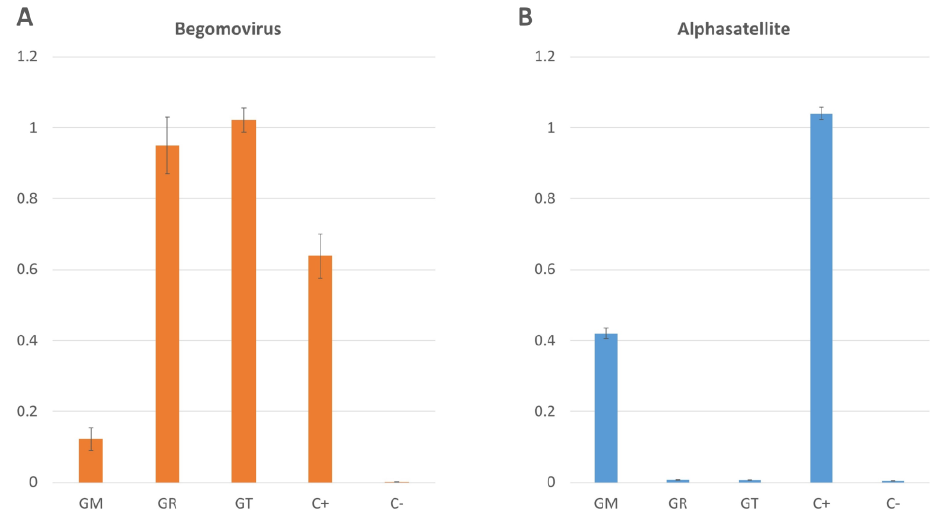
Figure 4. Quantitative analysis of begomovirus and alphasatellite. ( A ) qPCR with begomovirus specific primers where GM, GR and GT represent G. mustelinum , G. raimondii and G. thurberi , respectively. Cotton leaf curl disease (CLCuD) infected G. hirsutum plants were taken as positive control C+ and CLCuD free G. hirsutum was taken as negative control C-. ( B ) qPCR with alphasatellite specific primers. The titer of each component is given in ng / µ g of genomic DNA on the y-axis and is the mean of three replications. The error bars are the divergence from mean quantified value.